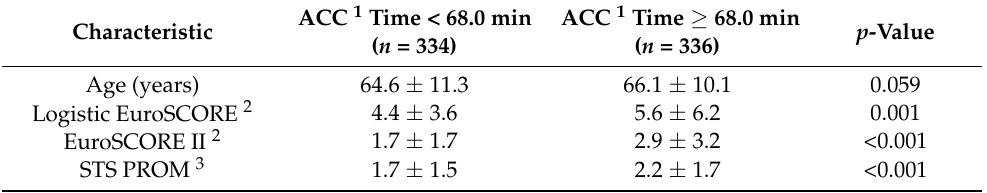
Table 6. Baseline characteristics of patients with ACC time of less than 68.0 min vs. 68.0 min or more. Characteristic